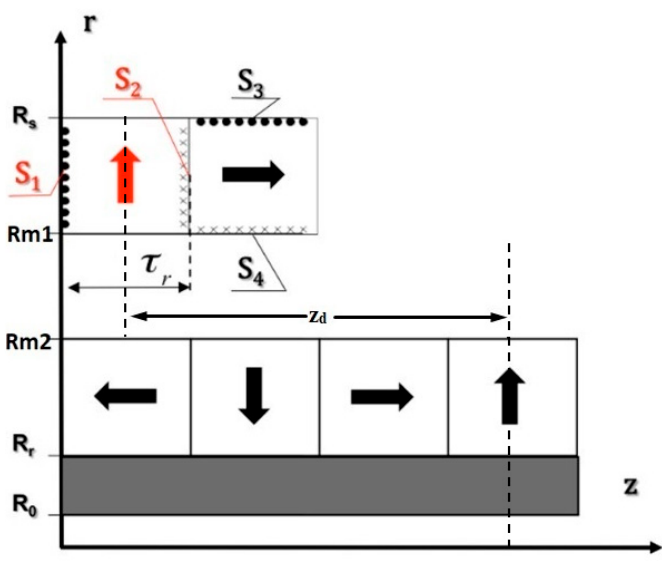
Figure 5. Force calculation over one pole pitch.